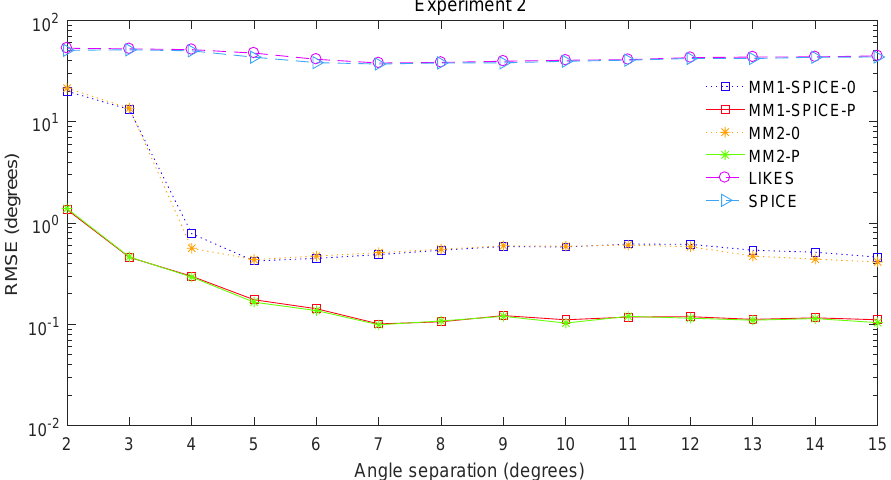
Figure 5. DOA estimation RMSE versus the angle separation ∆ ξ for Experiment 2 with n = 100 and SNR = 0